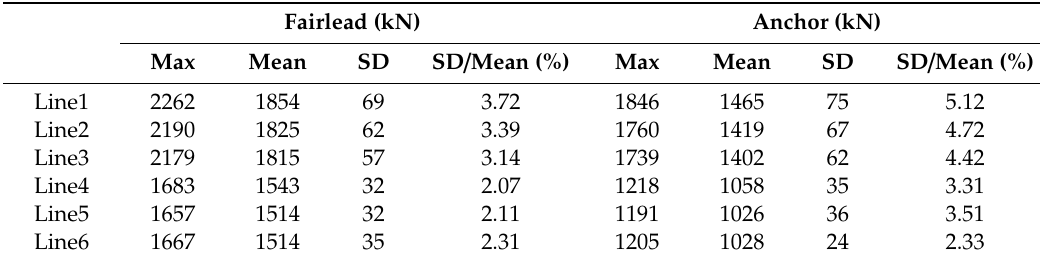
Table 10. Fairlead and anchor point tension statistics in